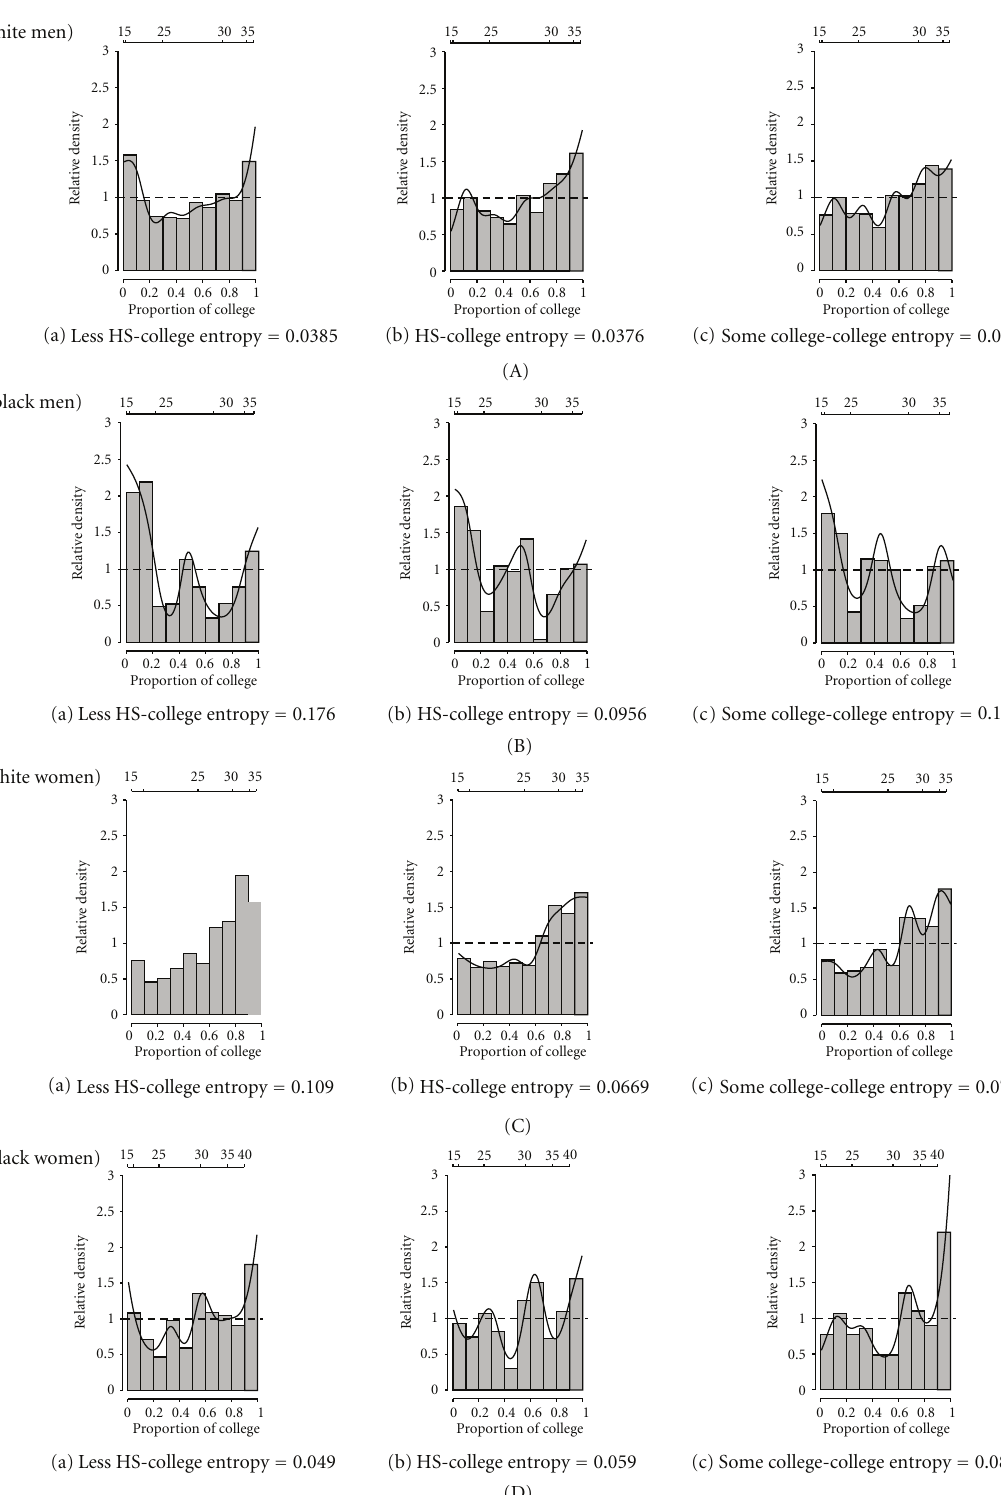
Figure 6: Age-adjusted relative body mass index distributions (1999–2006) between men (A, B) and women (C, D) and non-Hispanic Whites (A, C) and non-Hispanic Blacks (B, D) by those with a college degree or more compared to (a) those with less than a high school diploma; (b) those with a high school diploma or GED; (c) those with some college education. Deciles chart superimposed on relative densities. Abbreviation: NH: non-Hispanic. Data from the National Health and Nutrition Examination